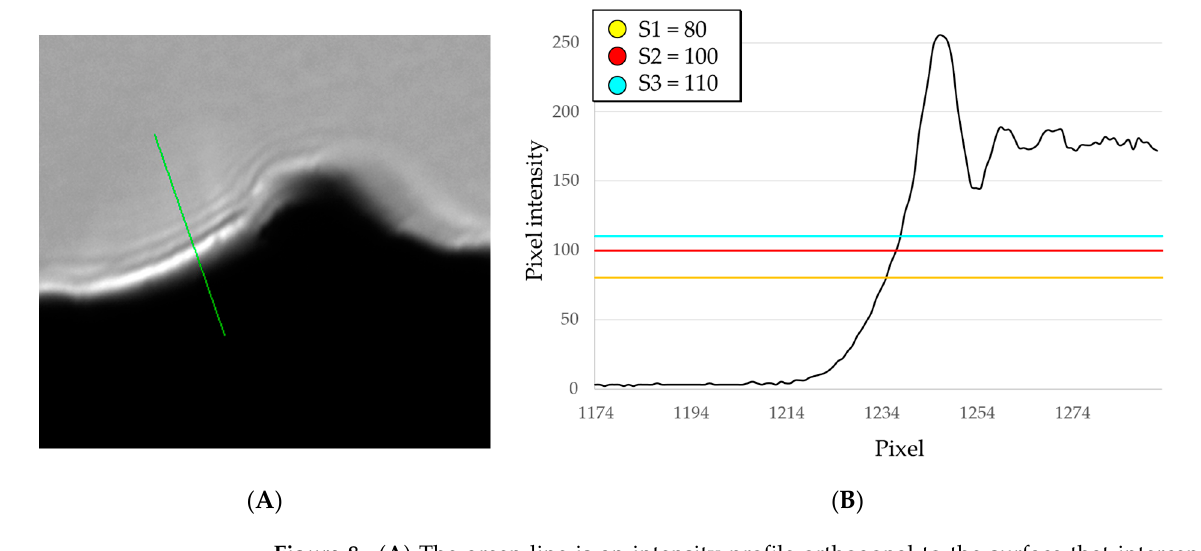
Figure 8. ( A ) The green line is an intensity profile orthogonal to the surface that intercepts the diffraction fringes. Image size is 350 × 350 pixels, corresponding to 0.2 × 0.2 mm; ( B ) Pixel intensity correlated to the green line: we see a transition from black to the first peak of the diffraction fringe followed by other smaller oscillations. Threshold values represent the cut-off values between black and white pixels in a binary representation of the image intensities: when the value changes the intensity transition is shifted either towards the black or towards the white.